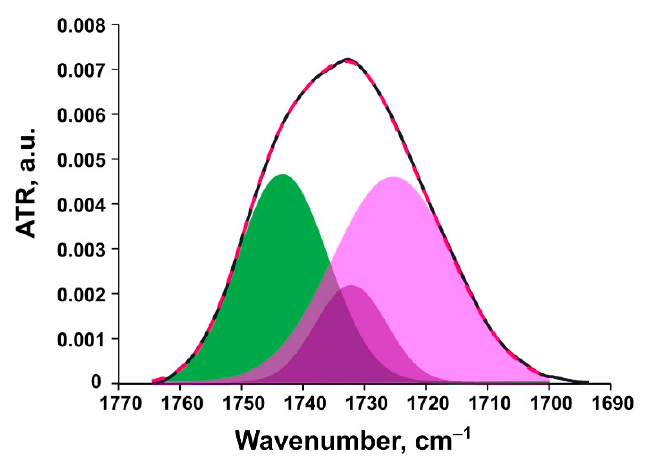
Figure 3. Experimental ester carbonyl peak for ePC liposomes (black line) and deconvolution components (green, free carbonyl groups; purple, highly hydrated carbonyl groups) with resulting fitting curve shown as a red dashed line.